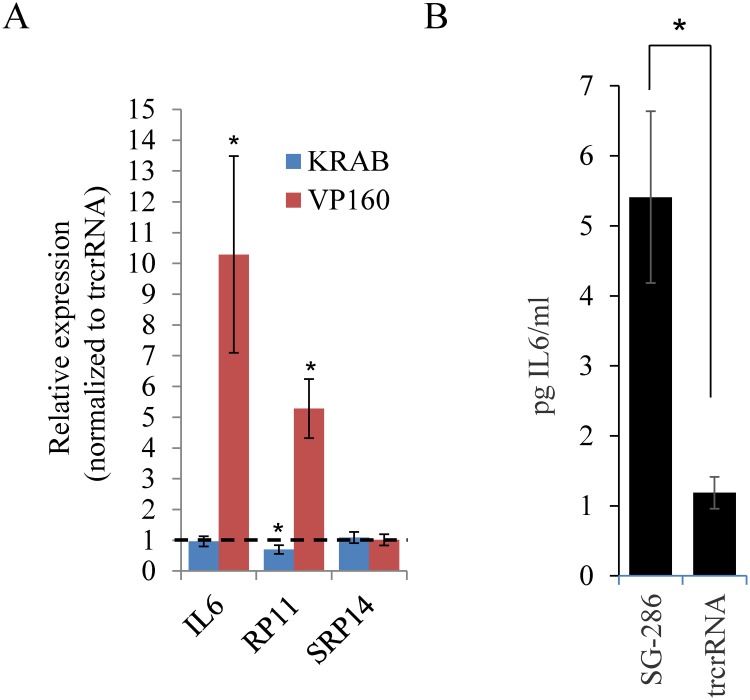
CRISPRa affects IL6 expression in HEK239T.A, regulation of RP11 transcription by repressive (KRAB) or activating (VP160) Cas9 derivatives. Cells were transfected with an activator or a repressor, in the presence of SG-286 or trcrRNA alone. Set used was independent from Fig 5. Data from 3 independent experiments (except for [IL6/ RP11] + KRAB, 5 experiments). B, CRISPRa activation increases secreted IL6 levels. IL6 protein concentration was measured in the media of HEK293T cells transfected for 48 h with CRISPRa and either SG-286 or trcrRNA alone.